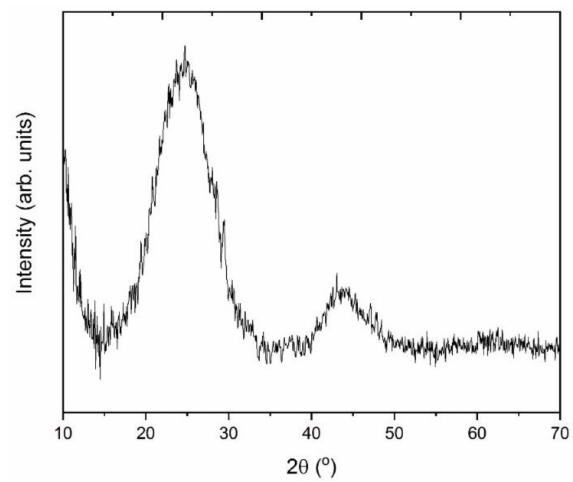
Figure 3. X-ray diffraction (XRD) pattern of the obtained